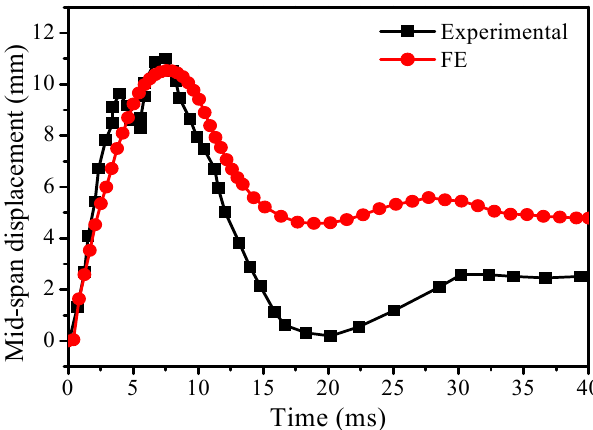
Figure 6. Comparison of mid-span displacement obtained from the FE simulation and the experimental test.